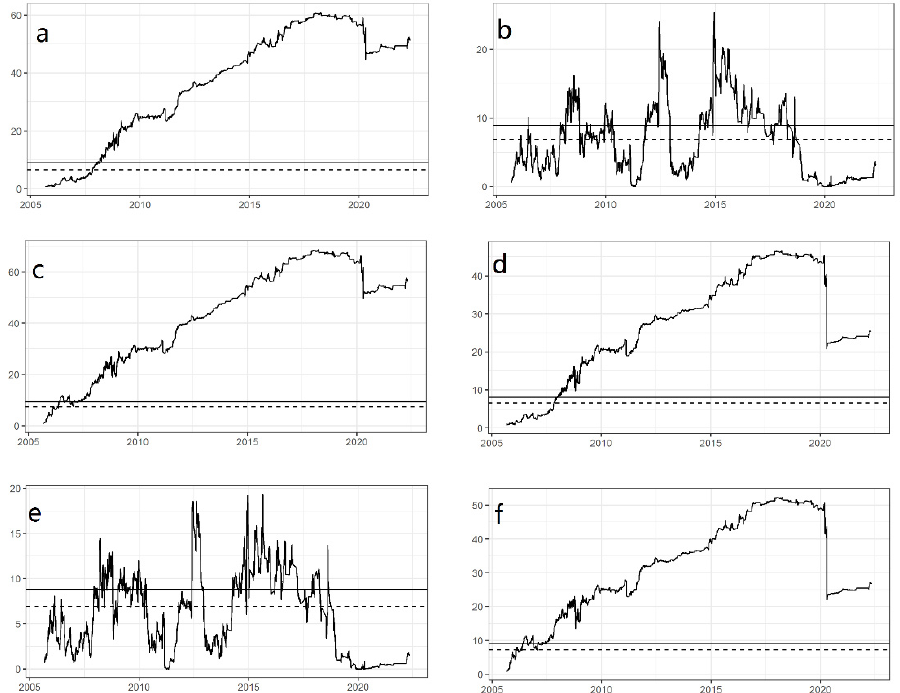
Figure 2. Results of time-varying Granger causality test ( WTI → AFI ). Note: The 90% and 95% con- fidence intervals are displayed with dotted and solid lines, respectively.